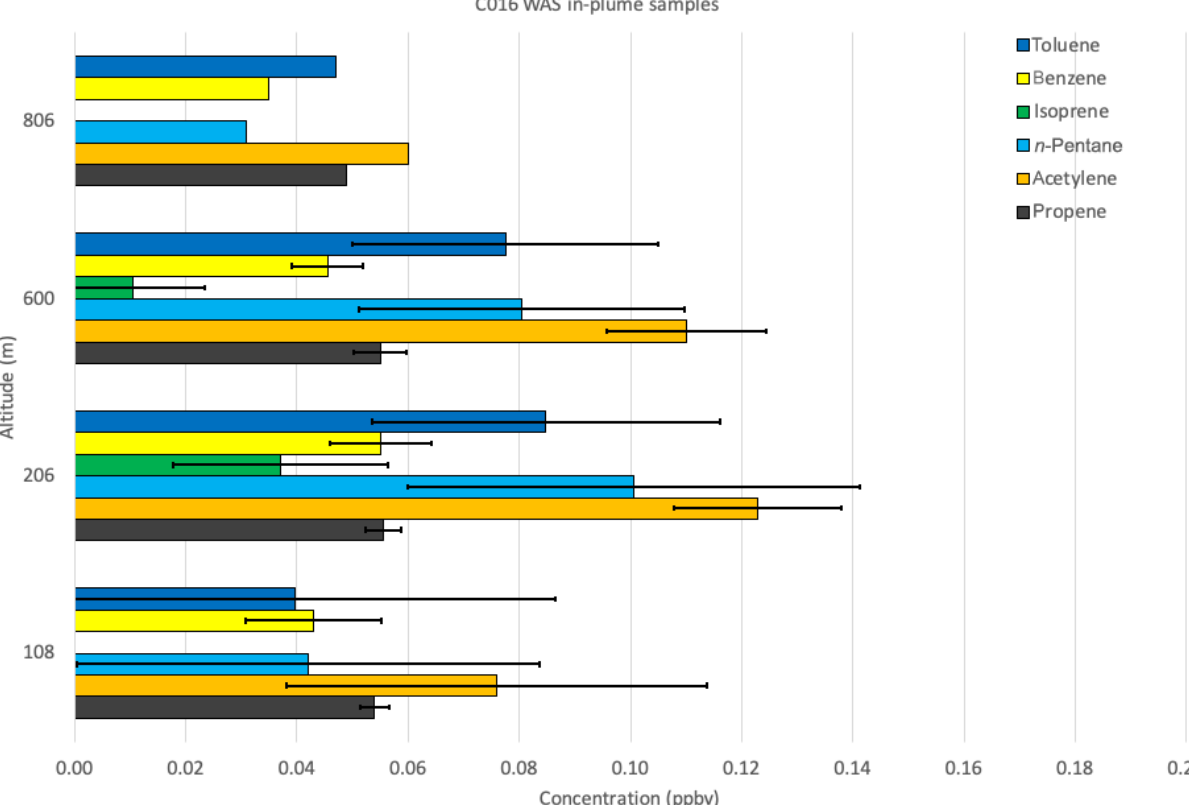
Figure 10. Average concentrations of key VOCs (ppbv) collected via WAS during individual flight legs within the plume detected during flight C016. The average altitude of each flight leg is shown on the y axis. Error bars denote ±